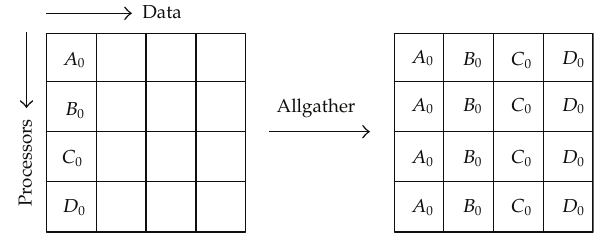
Figure 4: MPI collective communication